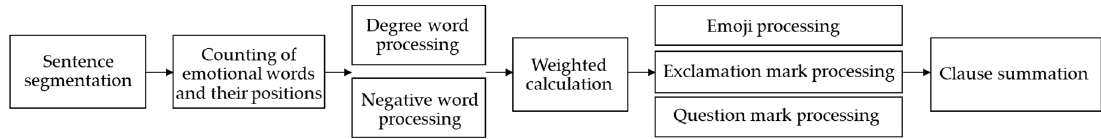
Figure 5. Flow chart of Weibo text scoring.